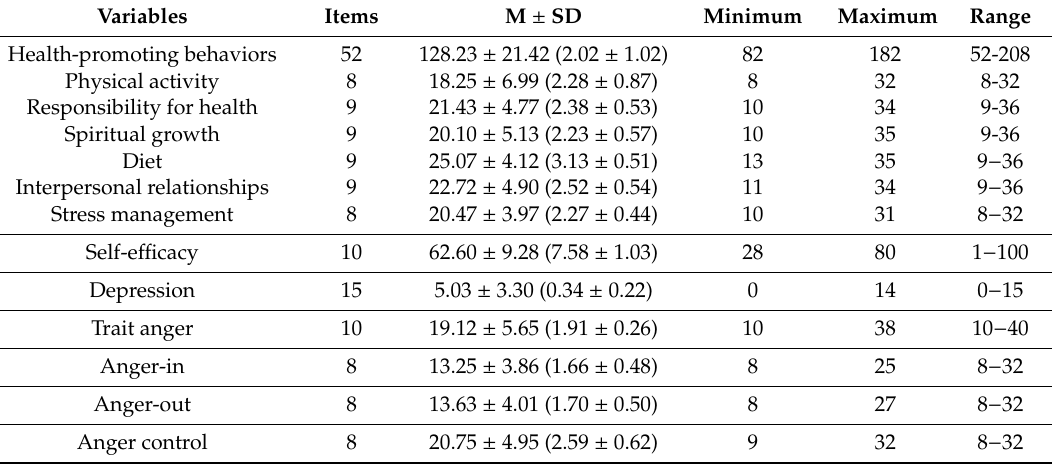
Table 3. Descriptive statistics and measured range of